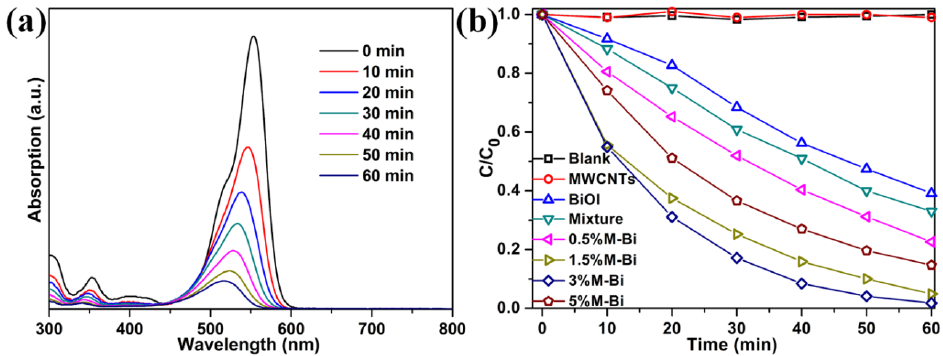
Figure 5. ( a ) UV-Vis absorption spectra of rhodamine B (RhB) dye versus reaction time over 3%M-Bi; ( b ) Photocatalytic degradation of RhB under visible light ( λ > 400 nm), in the absence of catalysts and in the presence of as-prepared catalysts (10 mg).